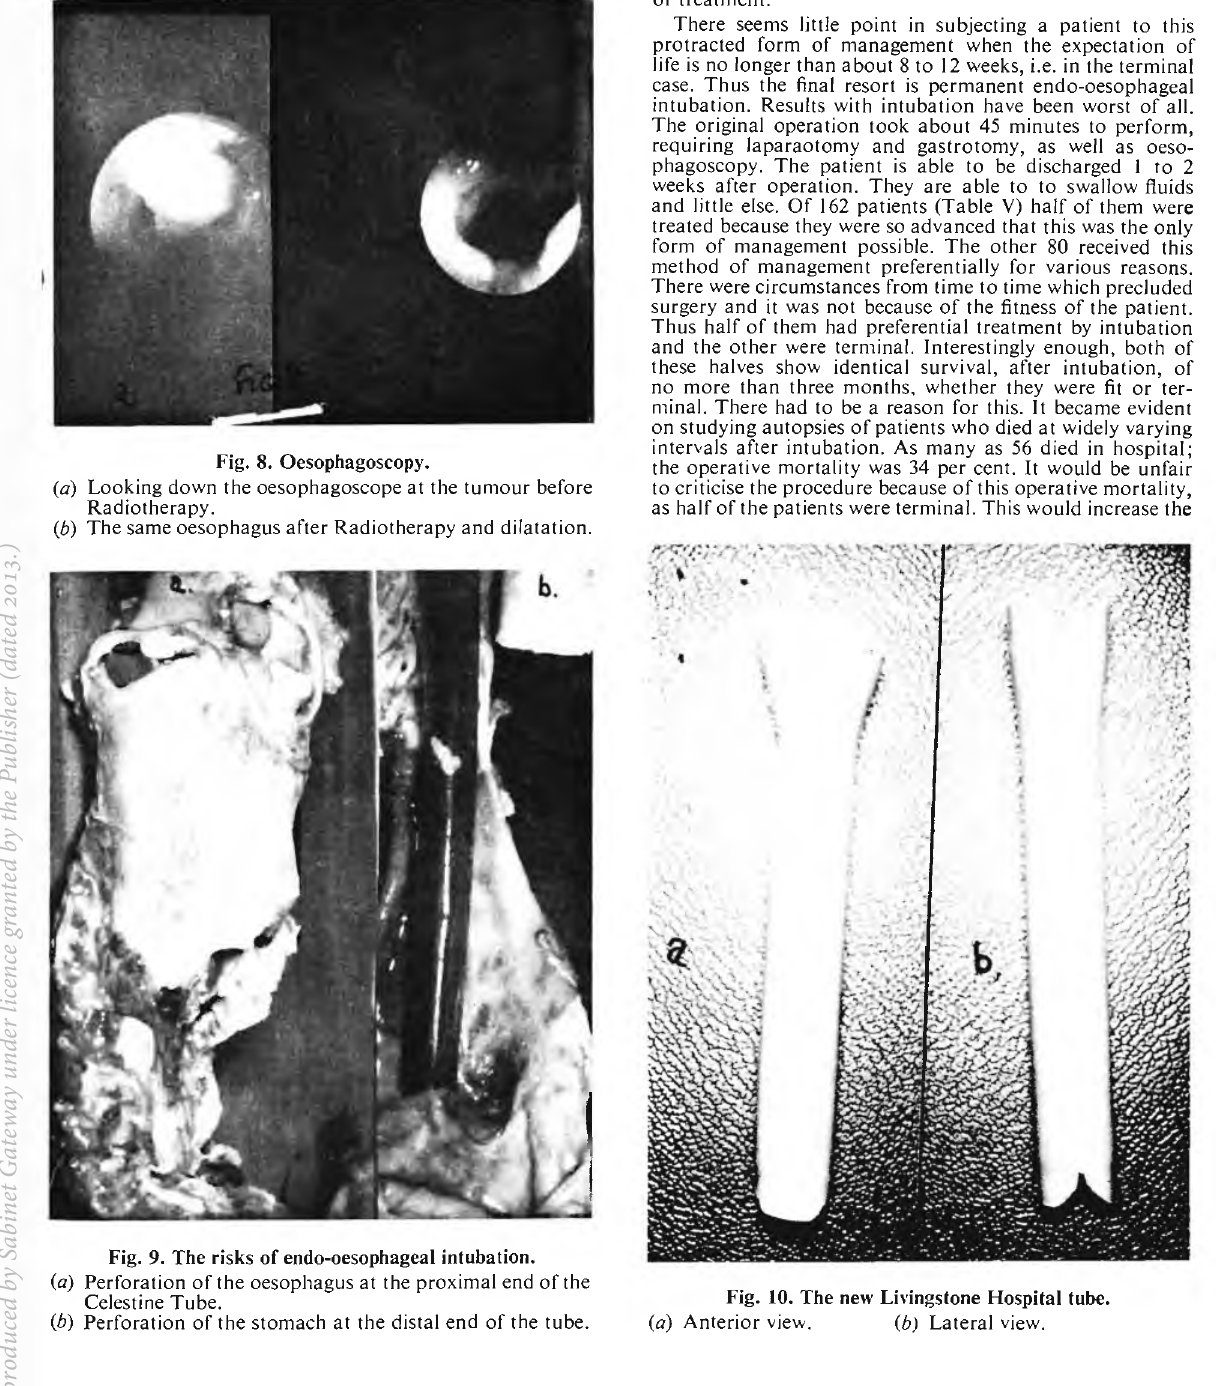
Fig. 10. The new Livingstone Hospital tube. (a) Anterior view. (b) Lateral